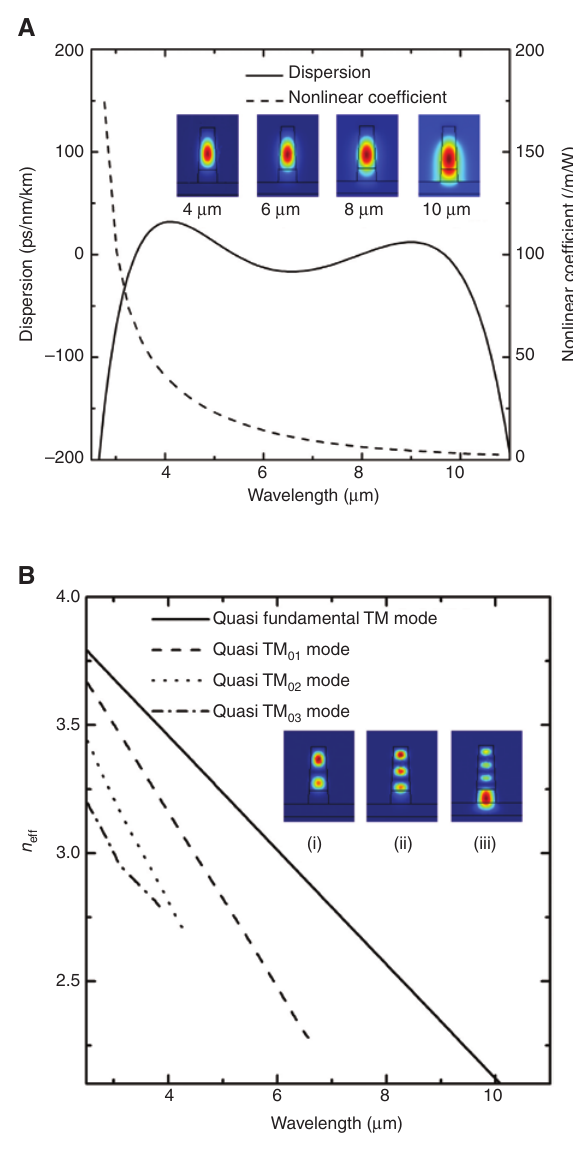
Figure 2: Dispersion, nonlinearity, and mode behaviors of the proposed waveguide. (A) A flattened and hybrid dispersion profile (solid) and the nonlinear coefficient (dashed) over a wide wavelength range in the mid-IR. Insets: Mode field distributions of the fundamental quasi-TM mode at 4, 6, 8, and 10 μ m wavelengths. (B) Effective indices of higher-order TM modes versus